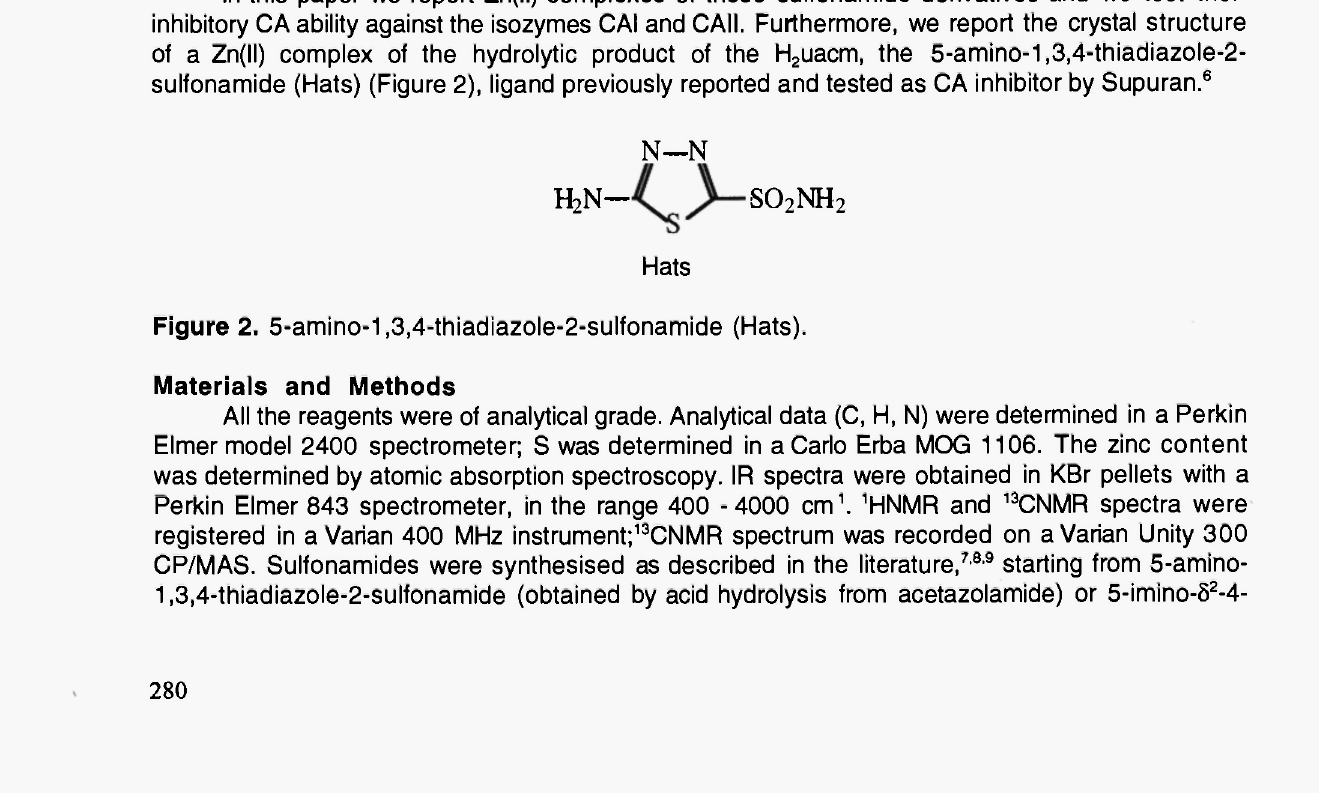
uacm), [2- 2 pyacm). 2